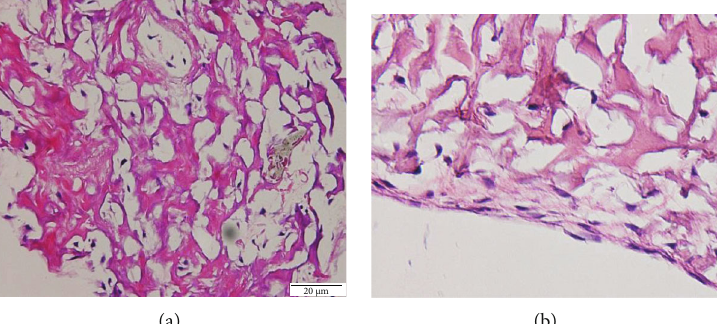
Figure 7: Human-derived derm-skin cartilage with attached mature chondrocytes at 21 days: H-E stain, magni fi cation 20x (a) and magni fi cation 40x